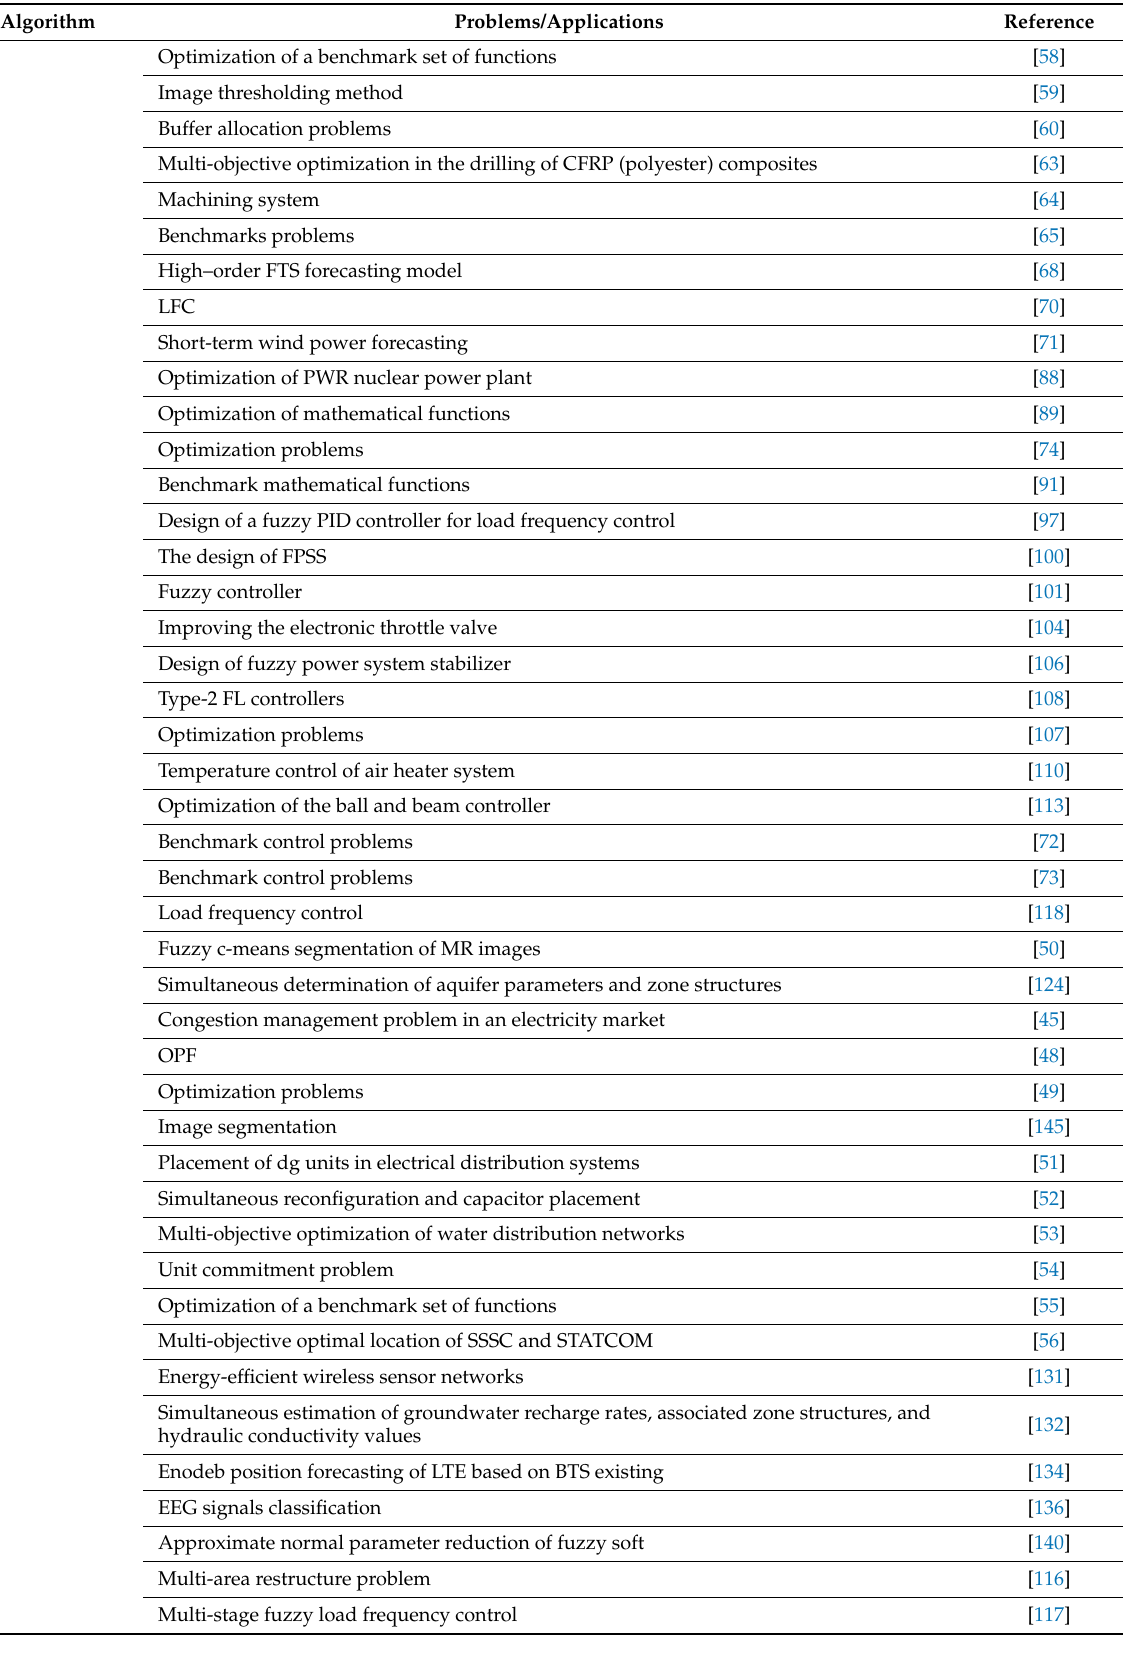
Table 6. Variants of HS algorithm combined with FL in the reviewed papers. Variants of HS